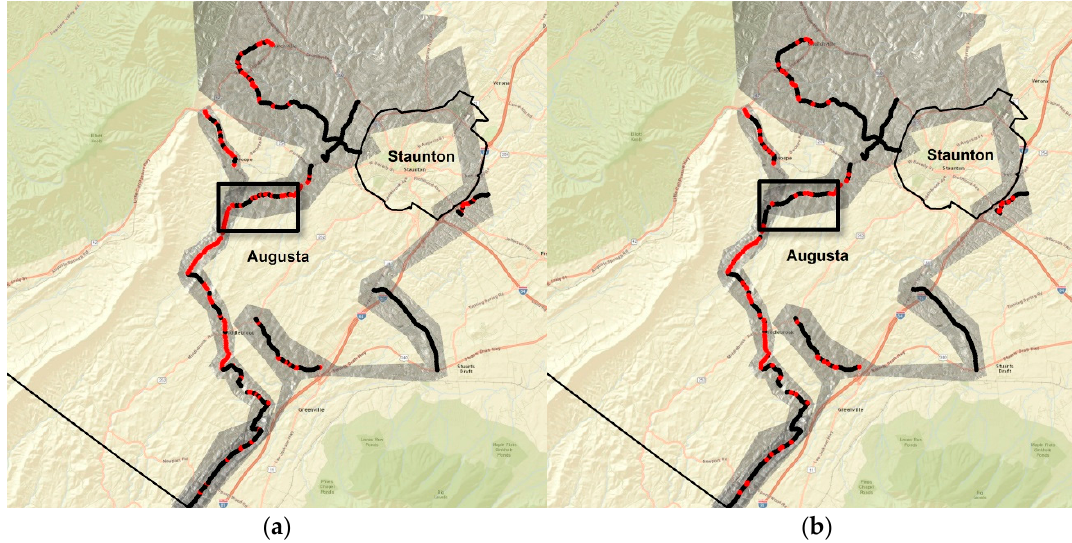
Figure 7. Distribution of good and bad road segments according to ground-truth IRI samples ( a ) and as classified using SAR amplitude data ( b ). The black rectangle indicates an area affected by misclassifications. This area is discussed further in Section 7.3 and Figure 9b.